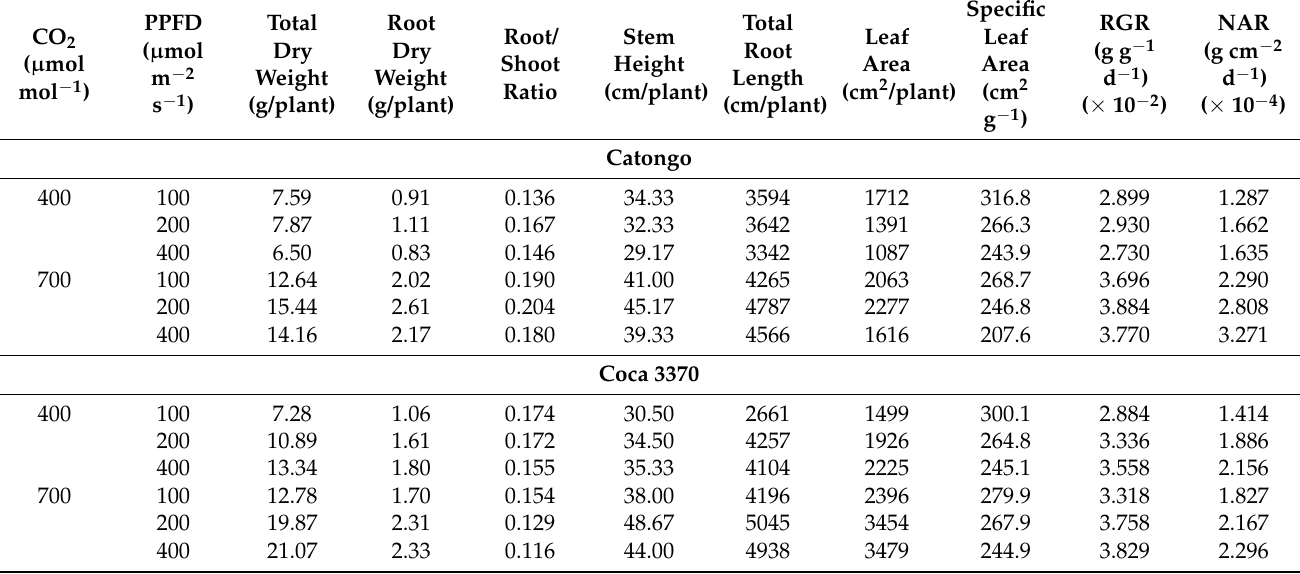
Table 1. The effect of [CO 2 ] and photosynthetic photon flux density (PPFD) on shoot and root growth, leaf growth, relative growth rate (RGR) and net assimilation rate (NAR) of seven cacao genotypes.